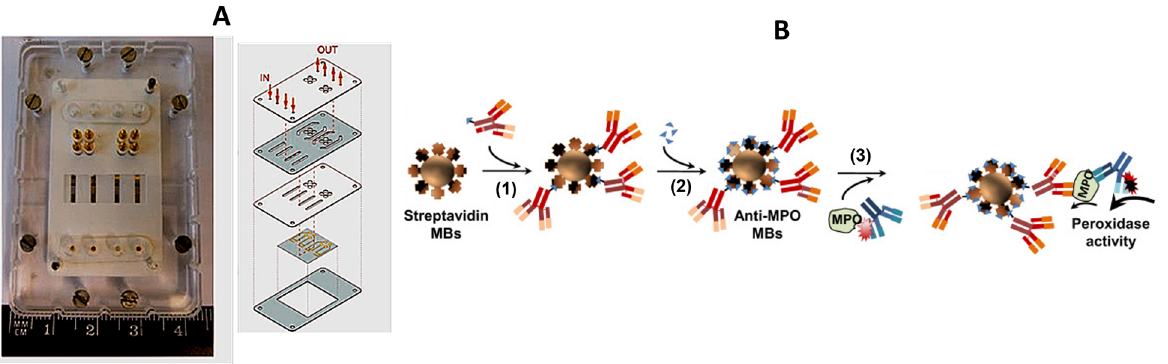
Figure 4. ( A ) Microfluidic chip and holder, and the different components of the cartridge. ( B ) Scheme of the magneto-immunoassay format for the determination of MPO: (1) anti-MPO-biotin; (2) biotin used as blocker; (3) anti-MPO-HRP. Adapted from [59] with permission.